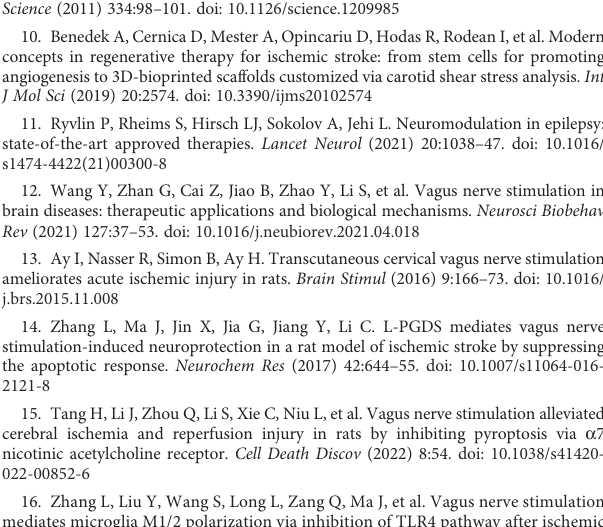
SUPPLEMENTAL FIGURE 1 The effect of VNS on USP10 expression and neuroin fl ammation in the cerebral cortex of mice without ischaemic stroke (Sham+VNS). (A) The USP10 protein expression on 1d and 3d after sham surgery and VNS treatment were assessed by western blot. (B) Histogram of the USP10 protein expression. n=3. (C) The expression of TNF- a , IL-1 b , and IL-6 were detected by ELISA. n=5. (D) Immuno fl uorescence images of Iba-1 + cells. Scale bar =100 m m. n=5. (E) Histogram representation of the quanti fi cation of Iba-1+ cell numbers. n=5. ns, no signi fi